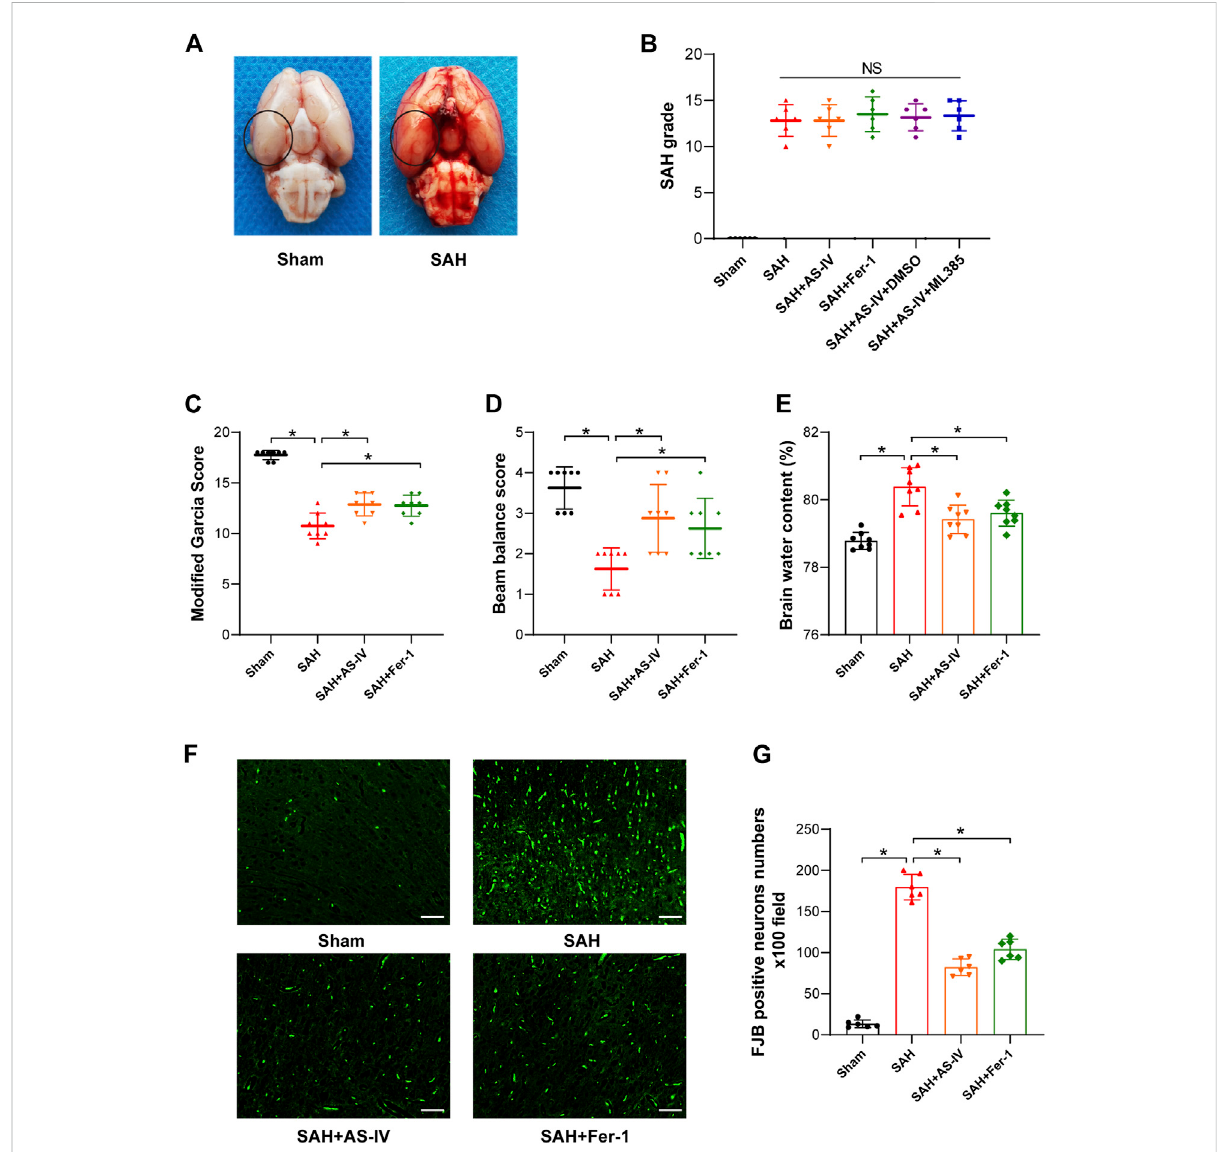
FIGURE 2 AS-IV and Fer-1 treatment improve EBI after SAH in rats. (A) Representative brain tissue images of rats in the Sham and SAH groups, the area in the circle represents the sampling site for Western blot and kit assay. (B) SAH grade scores 24 h after induction of SAH in rats ( n = 6). (C,D) Quantitative measurement of modi fi ed Garcia score and beam balance score ( n = 8). (E) Quanti fi cation of brain water content in various groups of rats at 24h post-SAH ( n = 8). (F) Representative images of FJB staining in the right temporal cerebral cortex of rats (scale bar = 50 μ m).